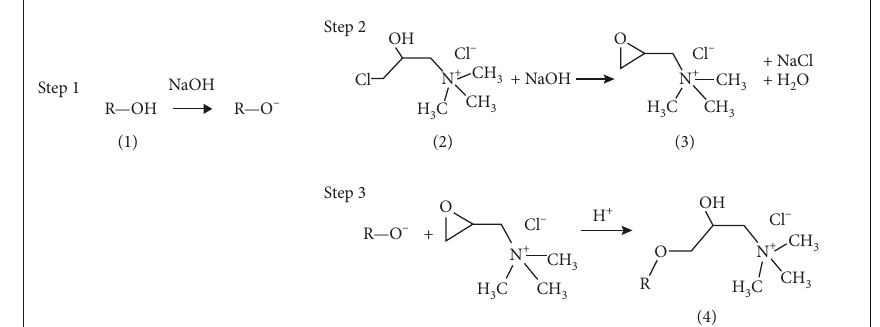
Figure 4: Lignocellulose quaternization reaction scheme: (1) cellulose, (2) N -(3-chloro-2-hydroxypropyl), (3) trimethylammonium chloride epoxide, and (4) quaternized cellulose [30].